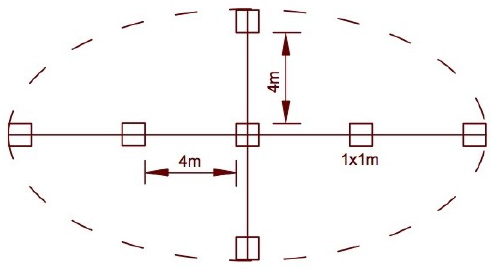
Figure 2. Location of subplots in sampling gap.